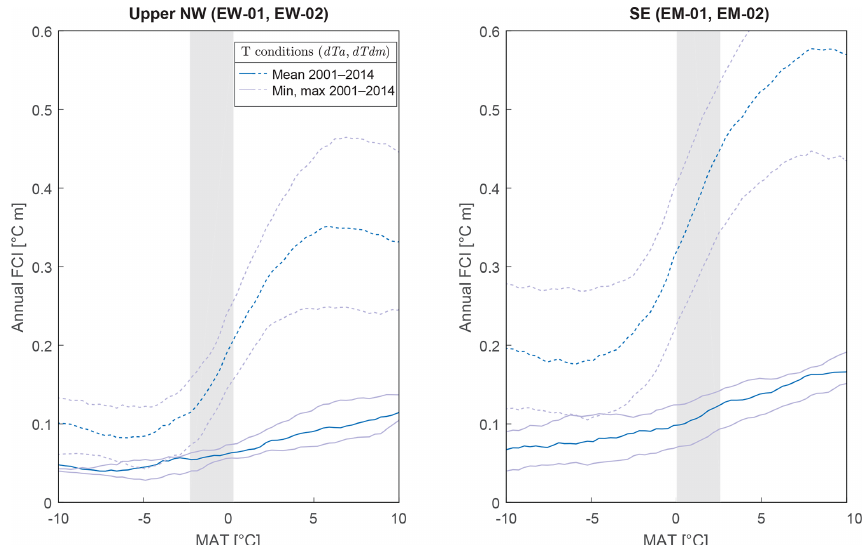
Figure B2. FCI sensitivity to thermal conductivity of bedrock (kr). Modeled results for FCI results with kr = 1.2Wm − 1 K − 1 (dashed lines) and kr = 6.5Wm − 1 K − 1 (solid lines), representing upper and lower thresholds for thermal conductivities compiled for various lithologies (Schön, 2015). Model set up to standard conditions of Andersen et al. (2015) for all other input variables. The shaded area corresponds to the reconstructed historic temperature